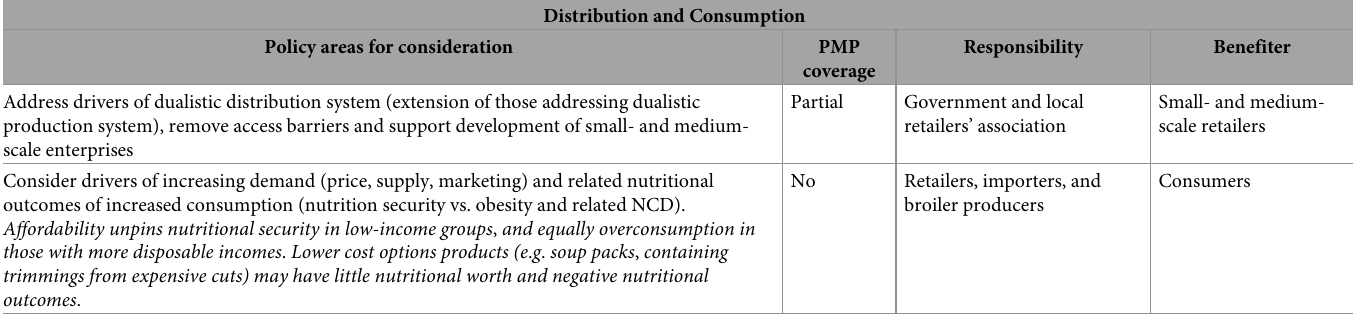
Table 2. Summary of distribution and consumption policy areas for consideration. Original ideas presented in meetings are in plain font, and stakeholder additions in italics (PMP = Poultry Master